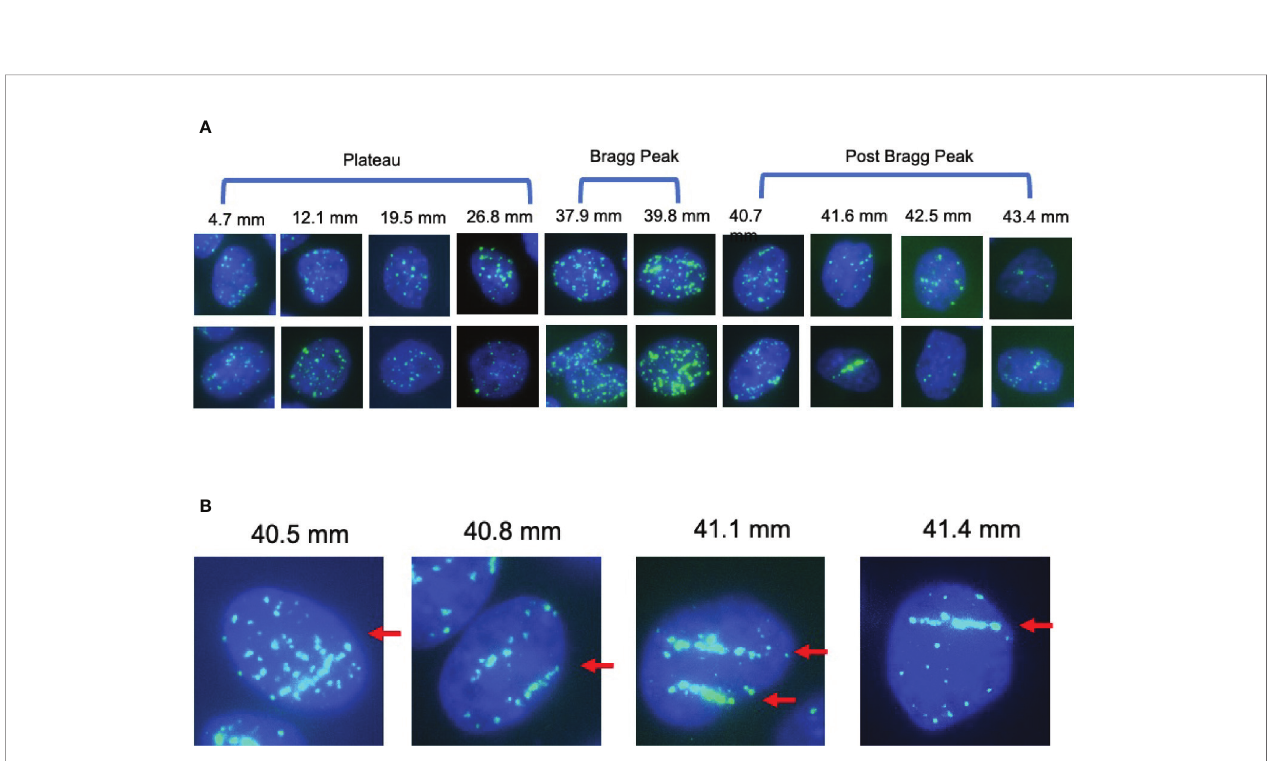
FIGURE 3 | g -H2AX foci after 1 Gy of proton beam irradiation for CHO wild type cells. (A) Representative images of foci number and patterns at the speci fi c distance for CHO wild type cells after proton 1 Gy irradiation. Two images were chosen for each distance. (B) Representative images of foci alignment like a track structure for CHO wild type cells after 1 Gy of proton beam. Green signals indicate g -H2AX foci. Blue signals are nuclei stained with DAPI. Arrows indicate track like structures of foci